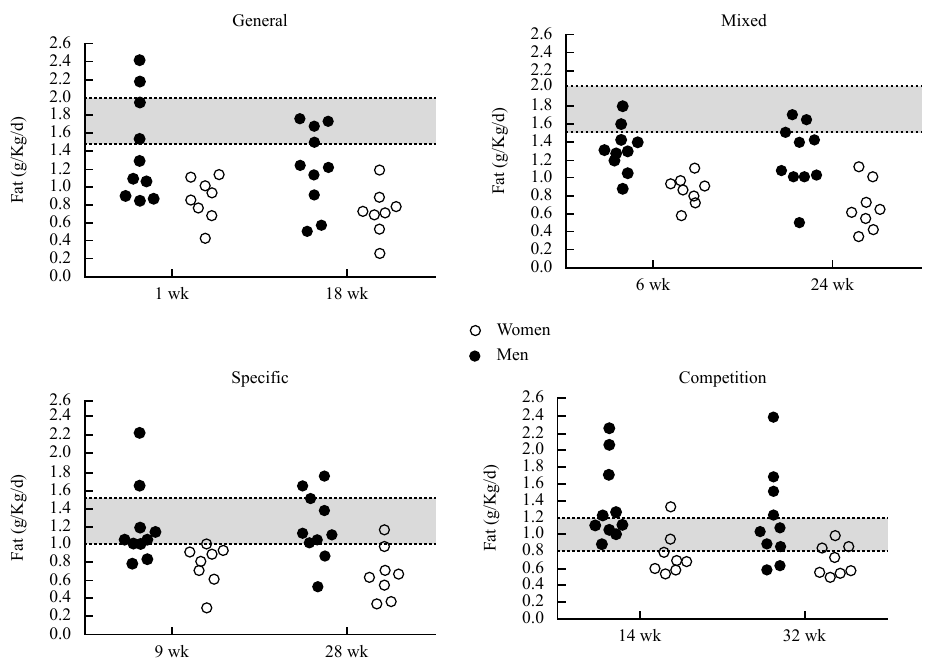
Figure 5. Individual fat intake and recommendation (grey band) for each training phase (in two macrocycles) by male (n=10) and female (n=8)